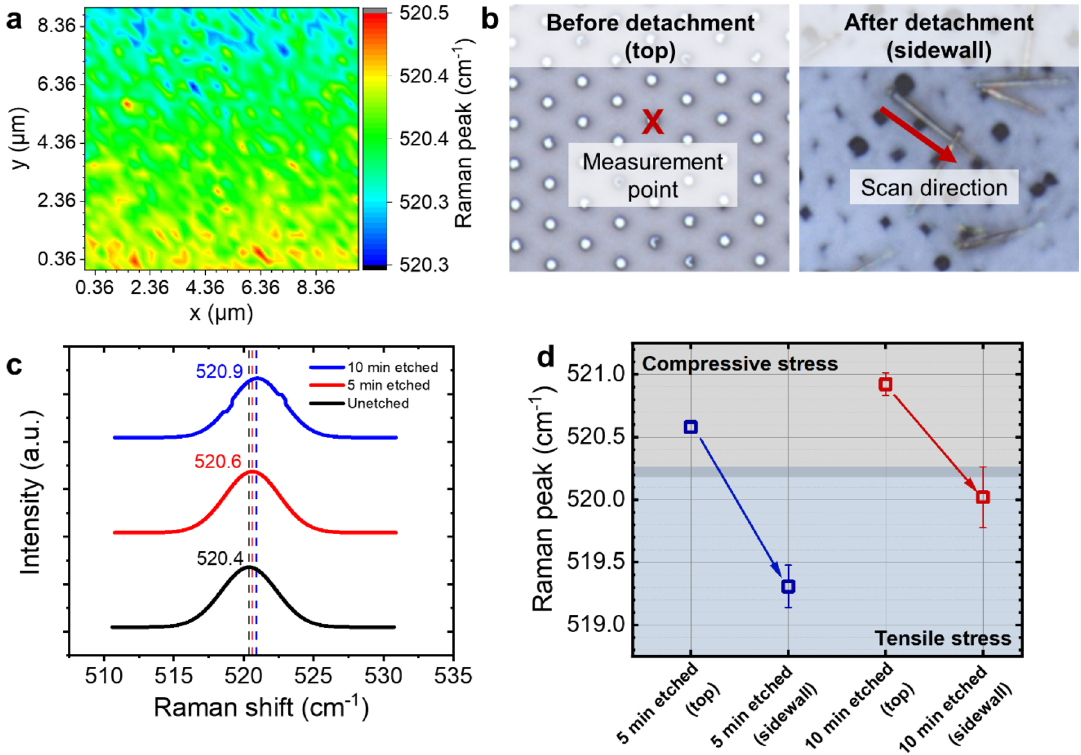
Figure 5. Raman measurements of Si nanowires produced by cryogenic dry etching. ( a ) Two-dimensional (2D) mapping of the dominant Raman peak at around 520.4 cm −1 represented by the triple degenerated optical phonon mode of unstrained planar Si, showing a homogenous distribution within ± 0.1 cm −1 . ( b ) Two different stages of Raman characterization of the Si nanowires (i.e., before and after their detachment from the substrate). ( c ) Effect of the etch time on the Raman peak shifts. Shifts of 0.2 cm −1 and 0.5 cm −1 towards higher wavenumbers occurred after the planar Si was nanopatterned and etched for 5 and 10 min, respectively, indicating the presence of compressive lattice stress in the nanowires. Raman spectrum of planar Si (black curve) is plotted as a reference. ( d ) Difference in mechanical property of Si nanowire between top and sidewall, corresponding to compressive and tensile stresses, respectively. This indicates an anisotropy of lattice stress distribution on the surface of Si